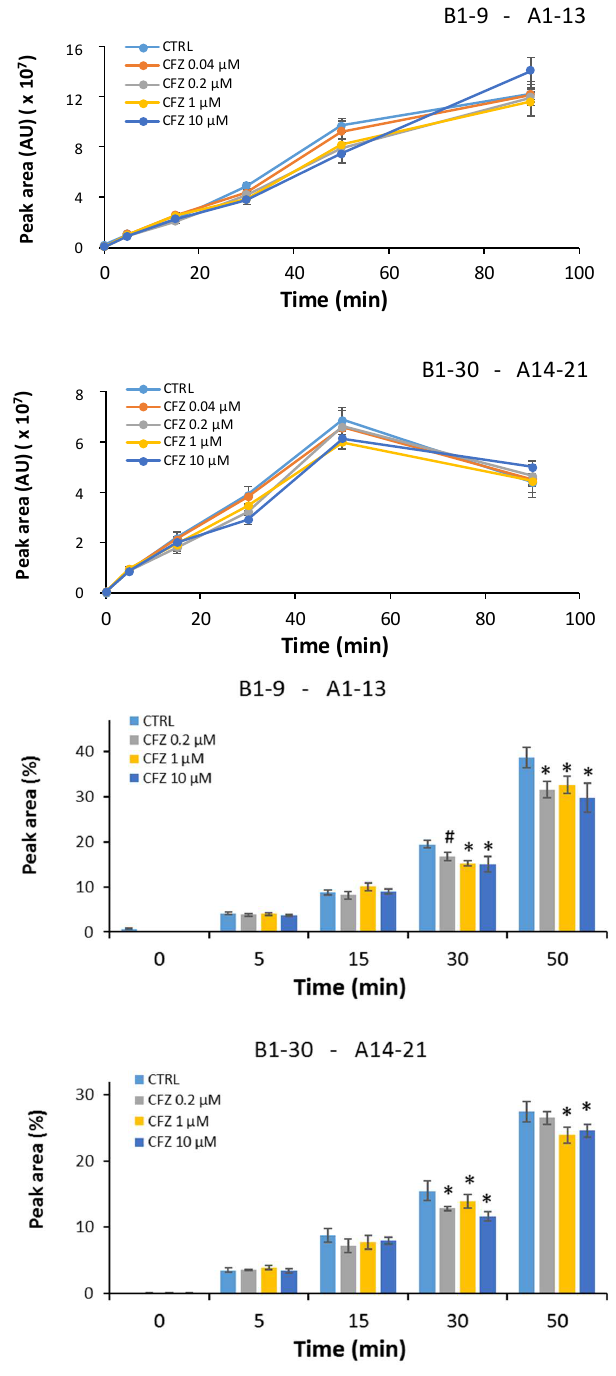
Figure 4. Dose-dependent effect of CFZ on the time-dependent formation of two main hydrolytic peptides (B1-9 -, 1-13 and B1-30 - A14-21), formed by the IDE-mediated degradation of insulin ( # p < 0.01; * p < 0.005). Data presented are mean ± SD ( n = 3) and are normalized to the Total Ion Current due to all the detected m/z signals. all the detected m/z